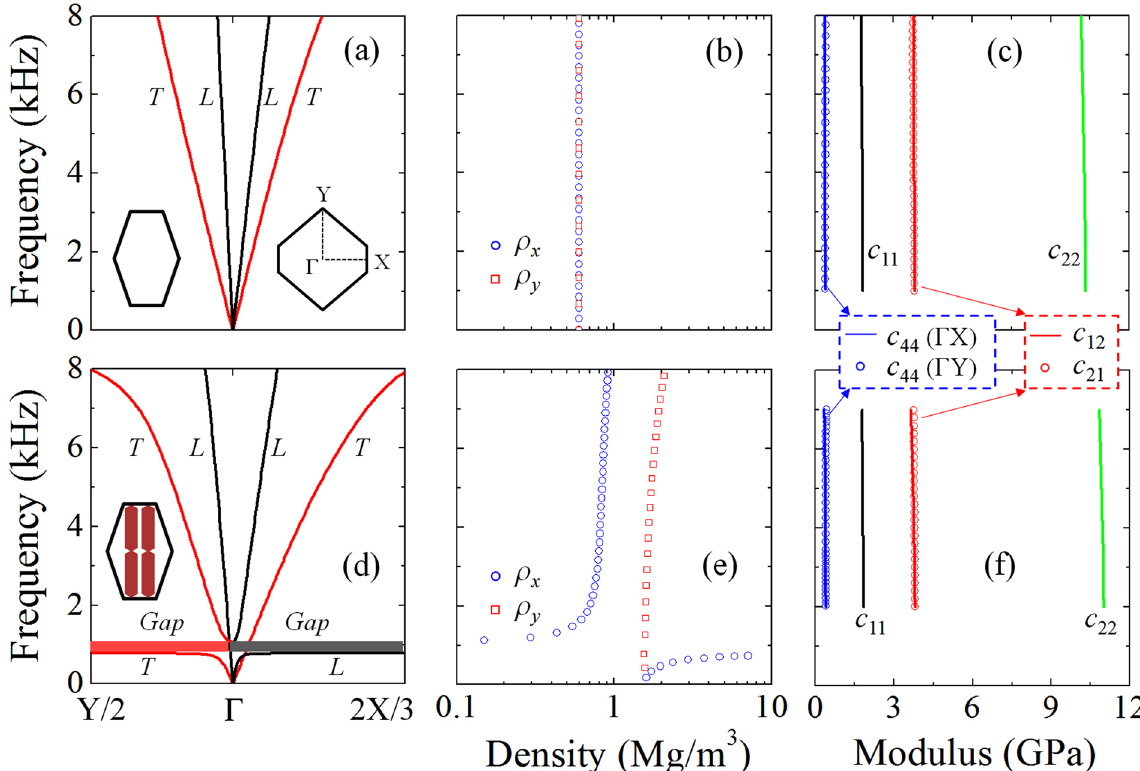
Figure 3. Wave characteristics of the dual-anisotropic material. Band structures of the pure lattice unit ( a ) and the metasolid cell ( b ) in two perpendicular Γ X and Γ Y directions, whose definition in the first Brillouin zone is shown in the inset. ( b ) Effective inertial densities and ( c ) stiffness parameters retrieved for the lattice host. ( e ), ( f ) Effective-medium parameters of the metasolid, showing that weakly dispersive dual anisotropy can be achieved in a broad frequency range ~2.0–6.0